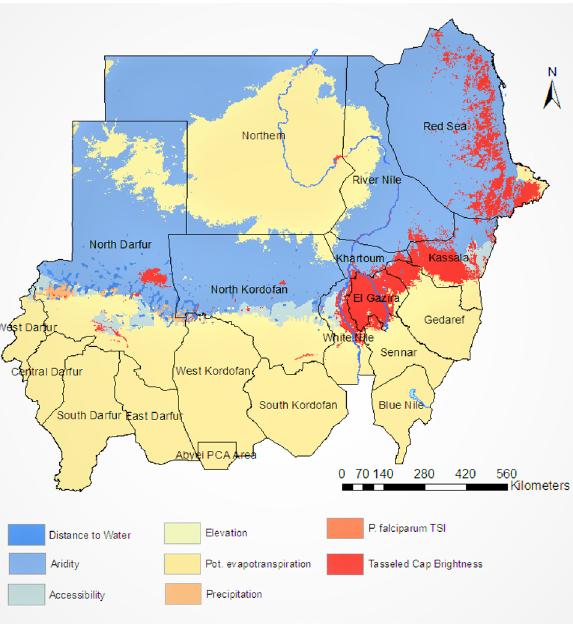
Figure 5. The covariates with the greatest positive influence in predicting the incidence rate, in each pixel, of Plasmodium falciparum malaria in Sudan. These covariates are associated with higher malaria incidence rate in the country.